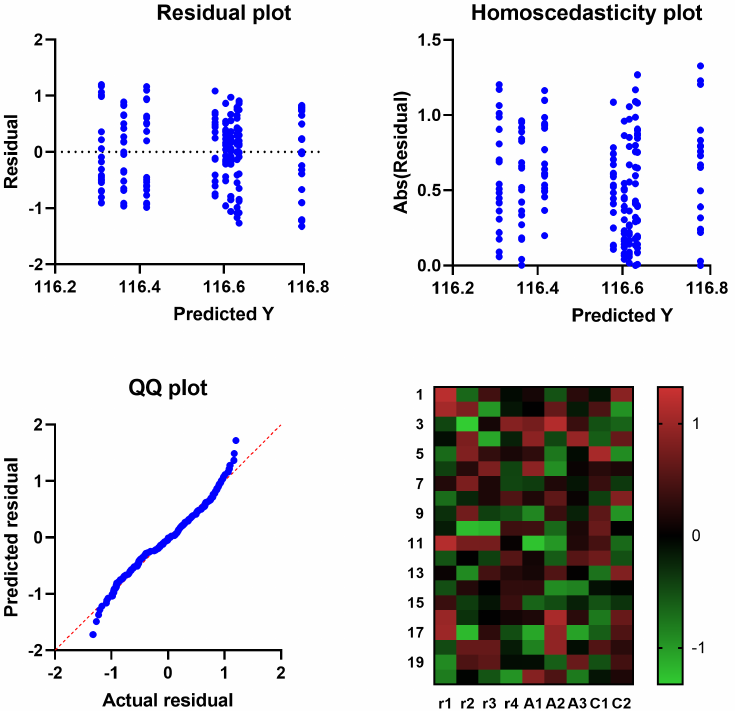
Figure 12. Residual, homoscedasticity, and QQ plots and heatmap of ADSCFGWO’s parameters ( r 1 , r 2 , r 3 , r 4 , A 1 , A 2 , A 3 , C 1 , and C 2 ) based on convergence fitness.